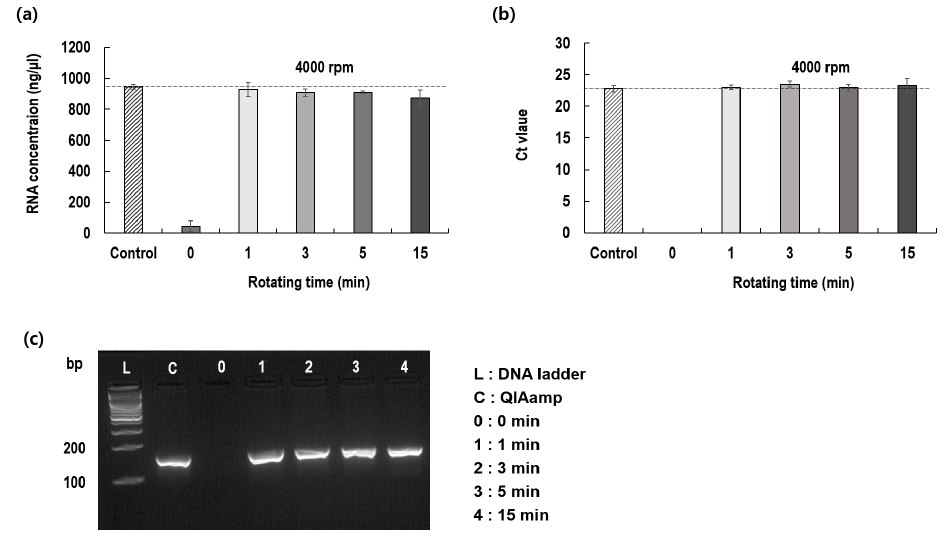
Figure 3. Effect of shearing time on viral RNA extraction as compared to control. ( a ) Extracted RNA concentrations; ( b ) Threshold cycles of PCR; ( c ) Gel-phoresis for amplified RNA.